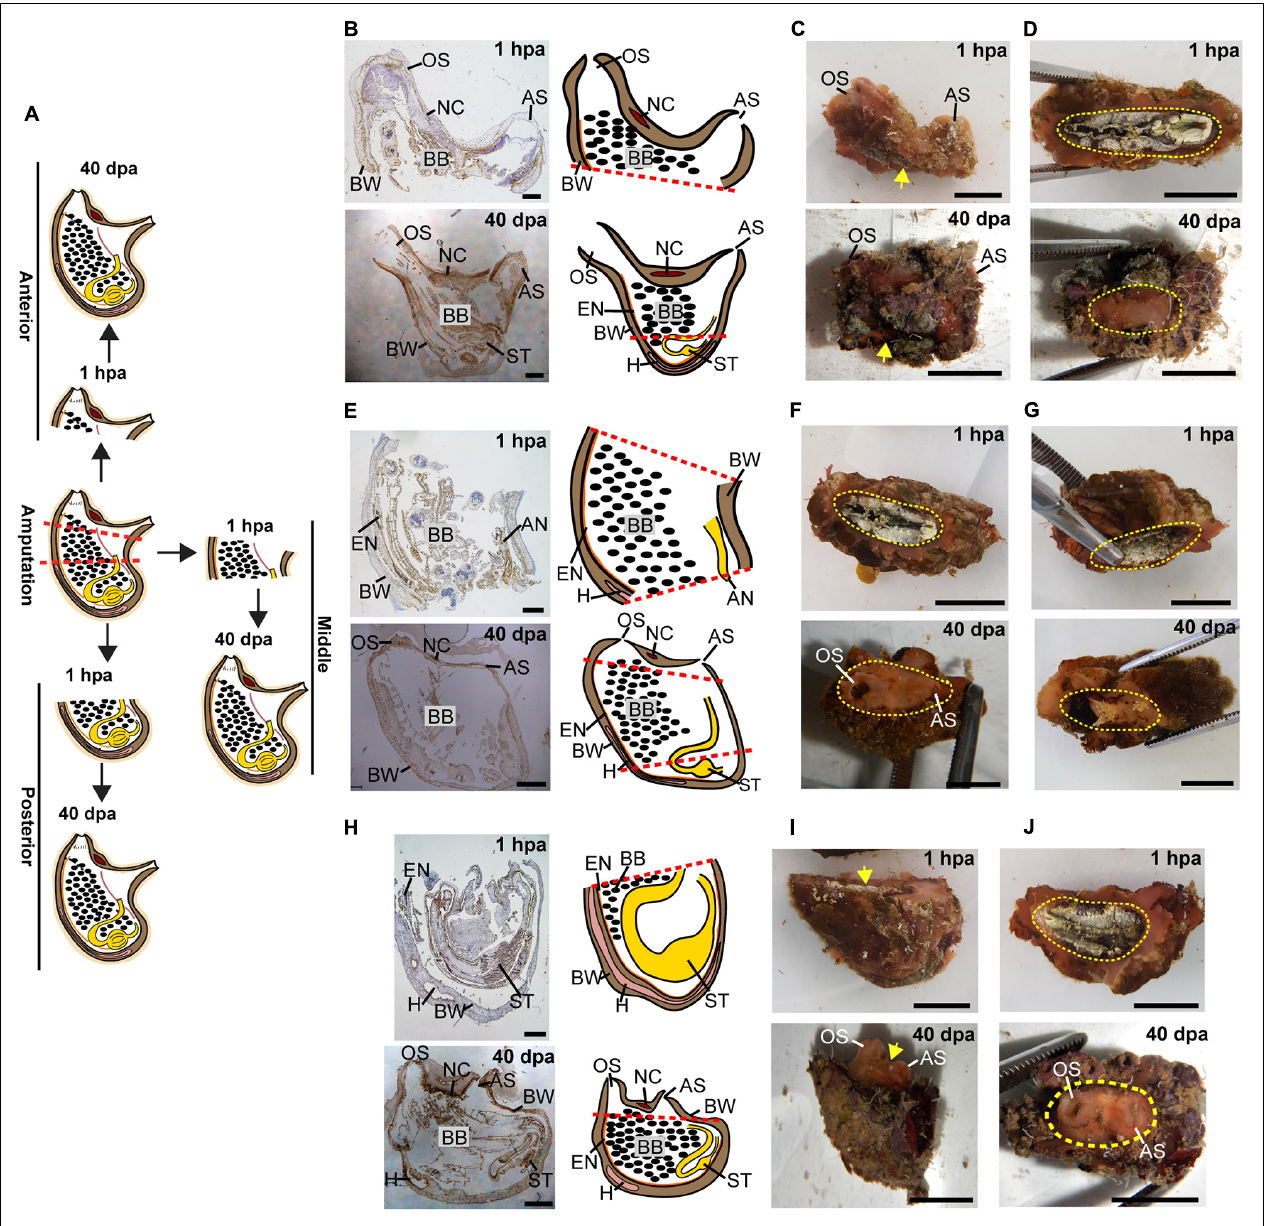
FIGURE 3 | Regeneration along the AP axis into three separate animals is complete by 40 dpa. (A) Illustration depicting regeneration process at 1 hpa and 40 dpa. (B–D) Regeneration of the posterior body part from the anterior fragment. (B) Sections left view and matching drawing. Red dashed lines indicate amputation line. (C) In vivo images, left view. Yellow arrow indicates wound area. (D) In vivo images, bottom view. Yellow dashed lines indicate wound border. (E–G) Regeneration of the anterior and posterior body parts from the middle body part. (E) Sections left view and matching drawing. (F,G) In vivo images of both sides of the animal. (F) Top view. (G) Bottom view. (H–J) Regeneration of the anterior body part from the posterior fragment. (H) Sections left view and matching drawing. (I) In vivo images, left view. (J) In vivo images, Top view. Anus (AN), atrial siphon (AS), body wall (BW), branchial basket (BB), endostyle (EN), heart (H), intestine (IN), neural complex (NC), oral siphon (OS), stomach (ST). Scale bar in (C,D,F,G,I,J) : 1 cm, and in: (B,E,H) : 2 mm (see also Supplementary Table 2 and Supplementary Figure 2